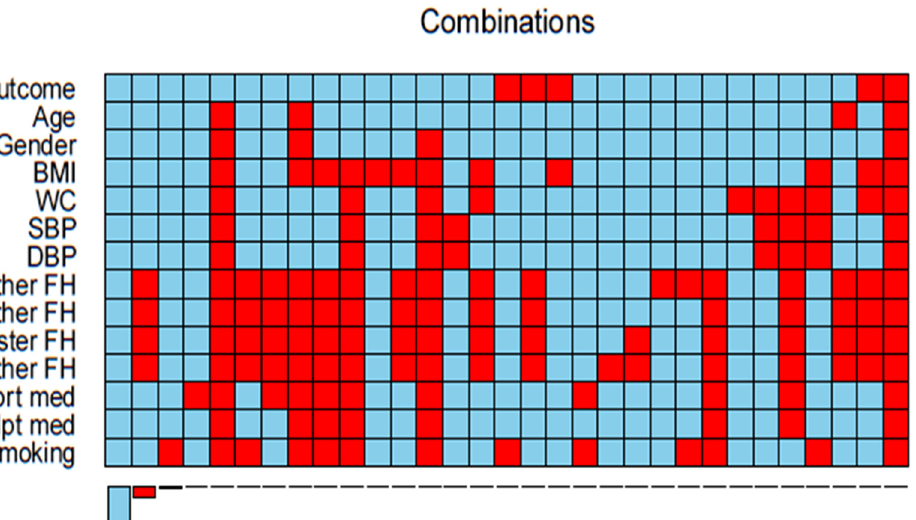
Fig 2. Aggregation plot showing all combinations of missing (red) and non-missing (blue) values in the variables, from the highest to lowest frequency. * BMI, Body Mass Index; WC, Waist Circumference; SBP, Systolic Blood Pressure; DBP, Diastolic Blood Pressure; FH, Family History; Cort, Corticosteroids; med, medication; Hpt,